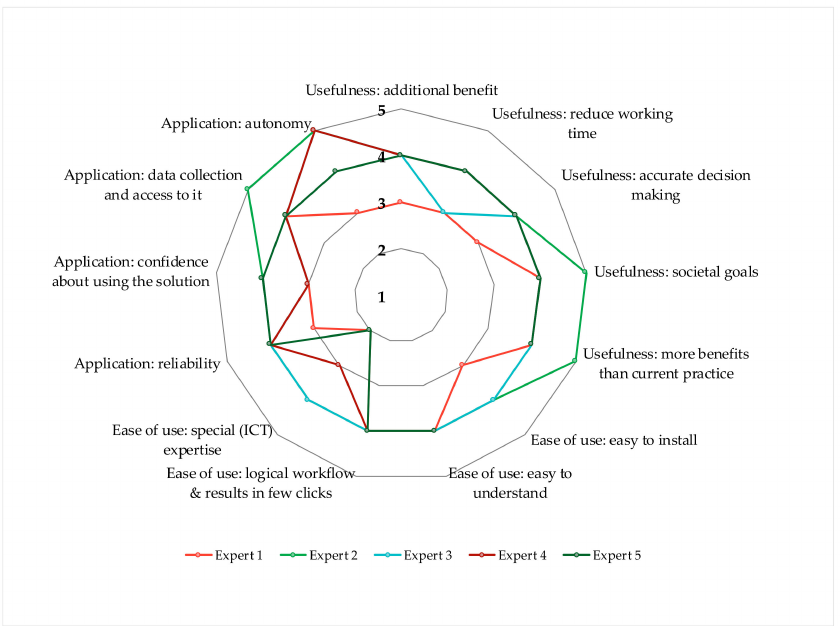
Figure 8. Responses of experts regarding the usefulness, ease of use and application of the smart farming solution. A 5-point Likert scale ranging from strongly disagree (1) to strongly agree (5) was